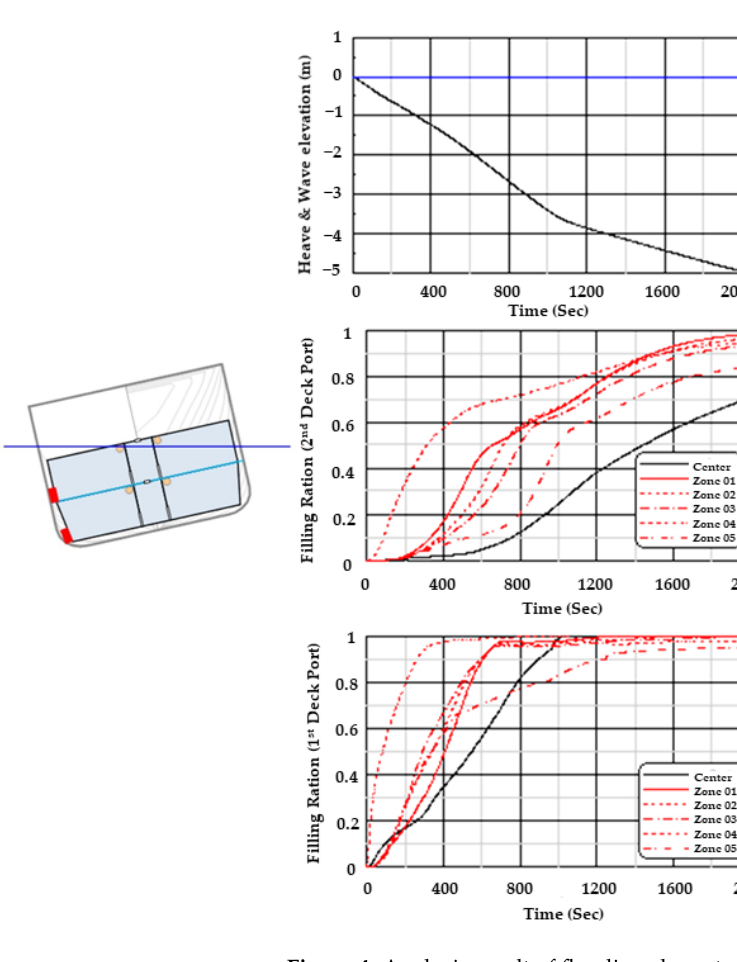
Figure 4. Analysis result of flooding characteristics of non-watertight area.